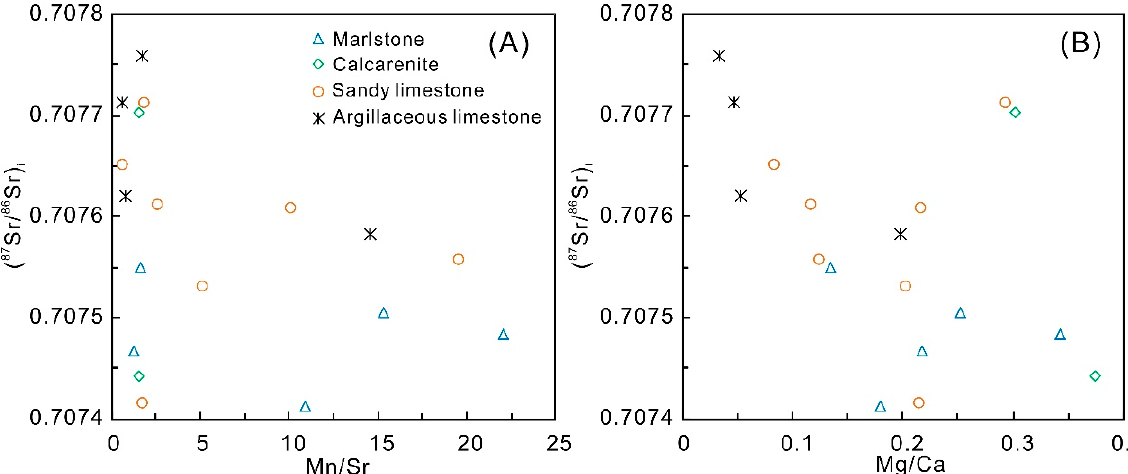
Figure 7. Cross-plots of ( 87 Sr/ 86 Sr) i vs. ( A ) (Mn/Sr) auth. and ( B ) (Mg/Ca) auth. for the associated wall rocks of the Ortokarnash Mn ore deposit.